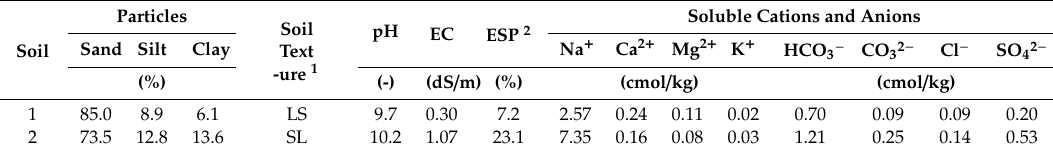
Table 2. Soil physical and chemical properties prior to the